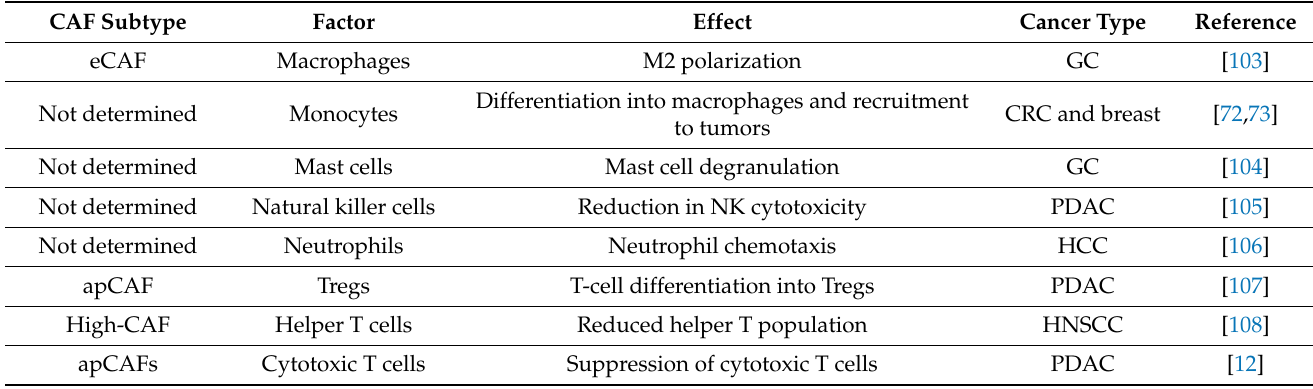
Table 2. Cancer-associated fibroblasts recruit pro-tumor immune cells while inhibiting recruitment of anti-tumor immune